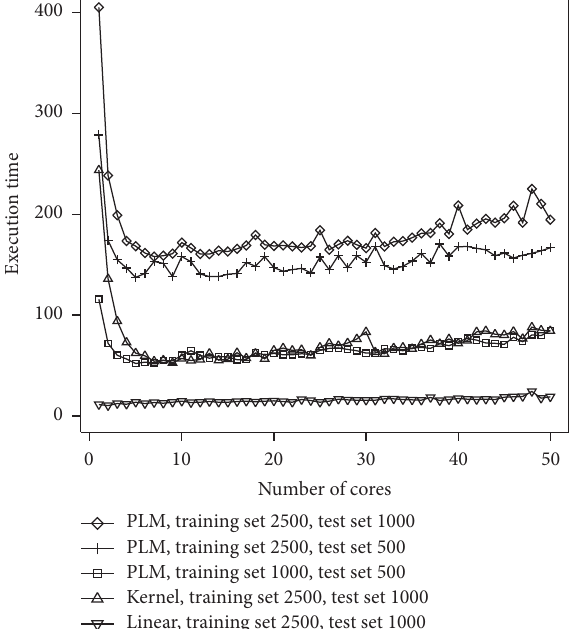
Figure 10: PLM algorithm execution time depending on the number of processing cores for traffic